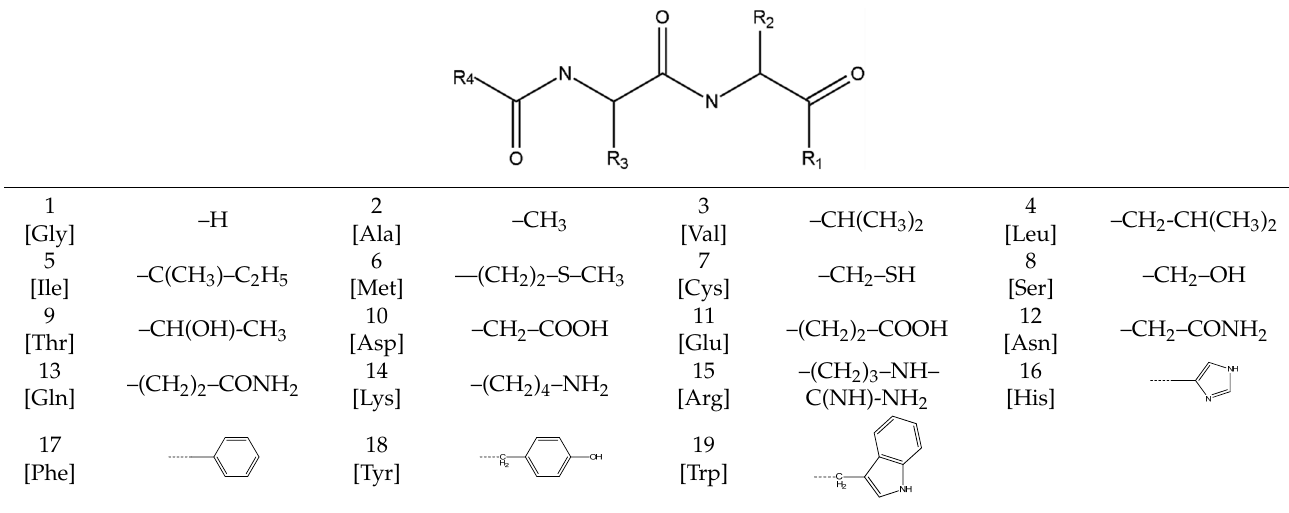
Table 6. R-groups (amino acid side chains) used in the design of the initial diversity library of PEP analogues. Dashed bonds indicate the attachment points of the fragments.